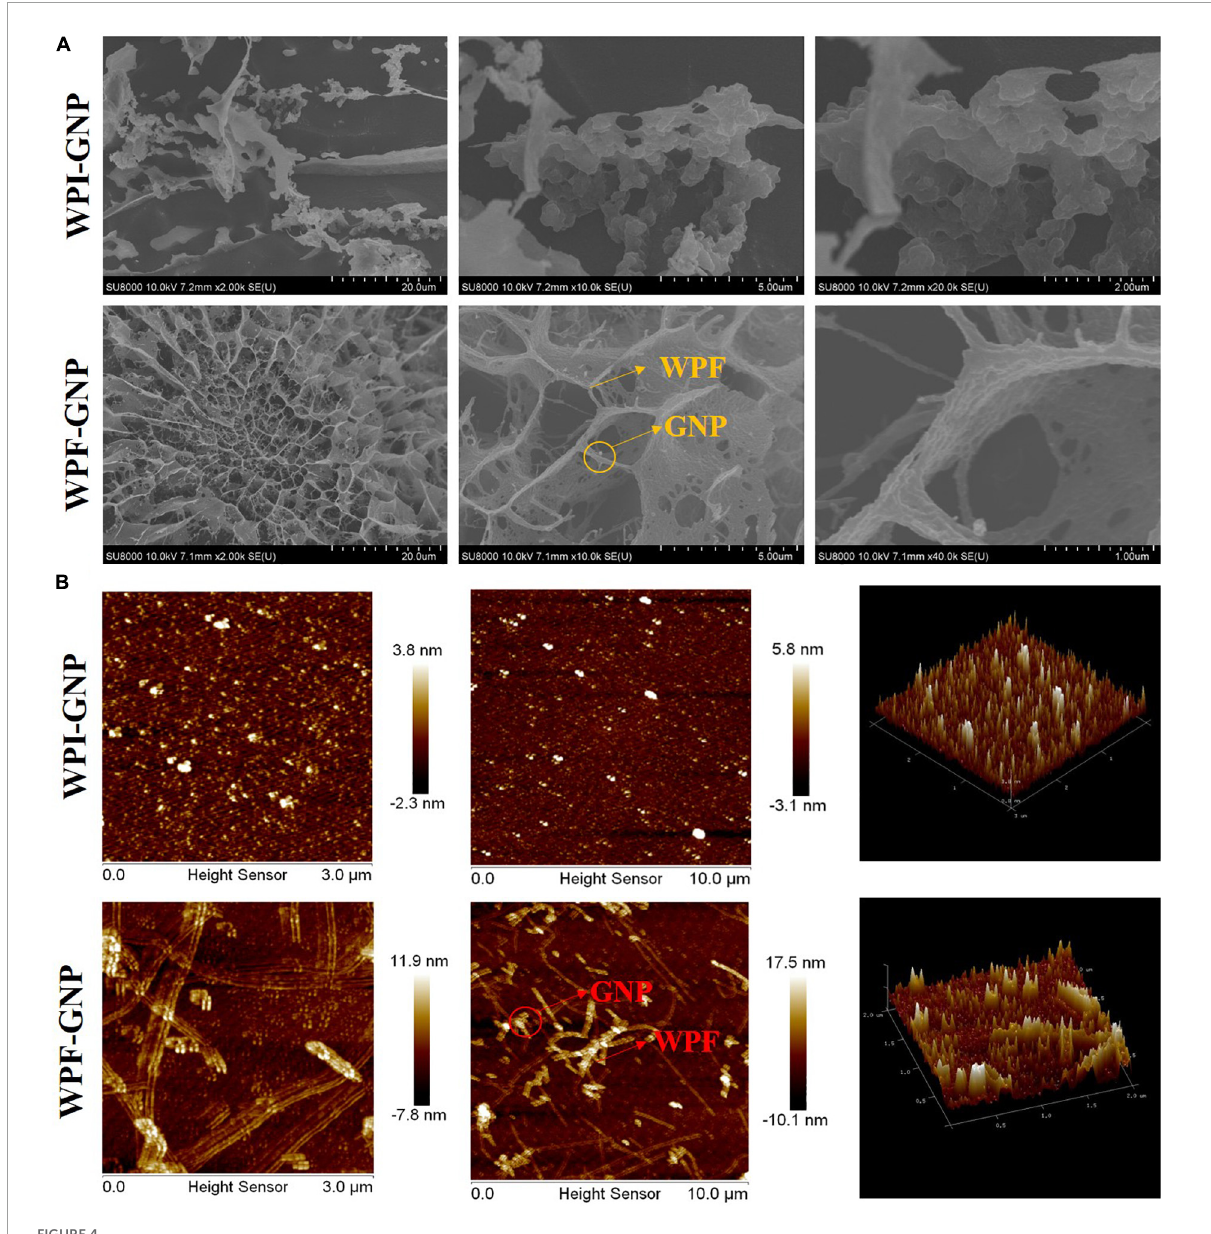
FIGURE4 (A) Cryo-SEM images of WPI-GNP hybrids and WPF-GNP hydrogel at ratio of 4:1 and pH 4.0; (B) AFM images of WPI-GNP hybrids and WPF-GNP hydrogel at ratio of 4:1 and pH